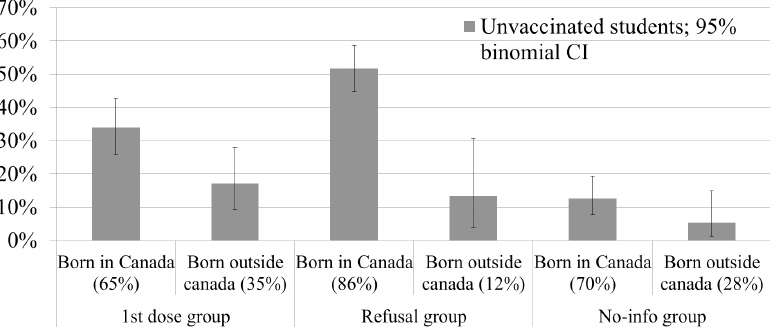
Fig 1. Proportion of unvaccinated students in each group sample by country of birth (Canada /outside Canada).